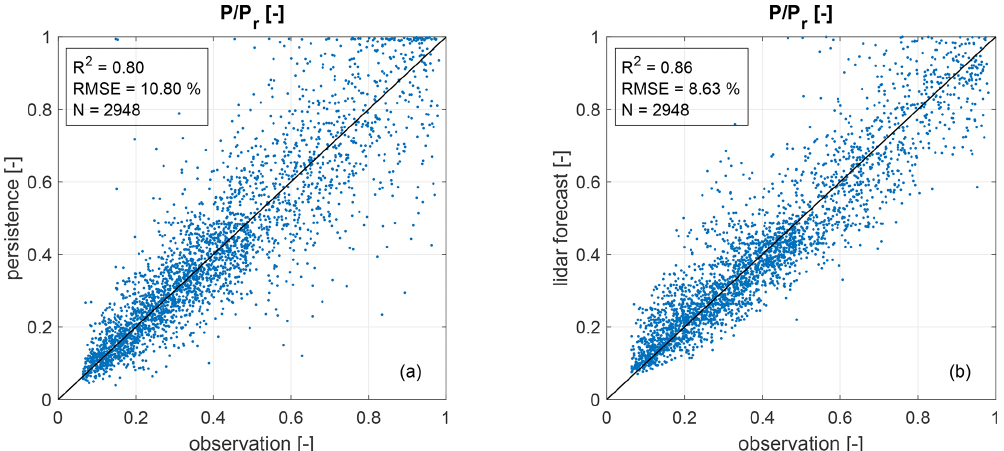
Figure 11. Comparison of 5min ahead power forecasts at turbine T3 with 1min mean SCADA data for (a) persistence and (b) the lidar-based forecast for unstable stratification. Values are given as a fraction of the turbine’s nominal power.